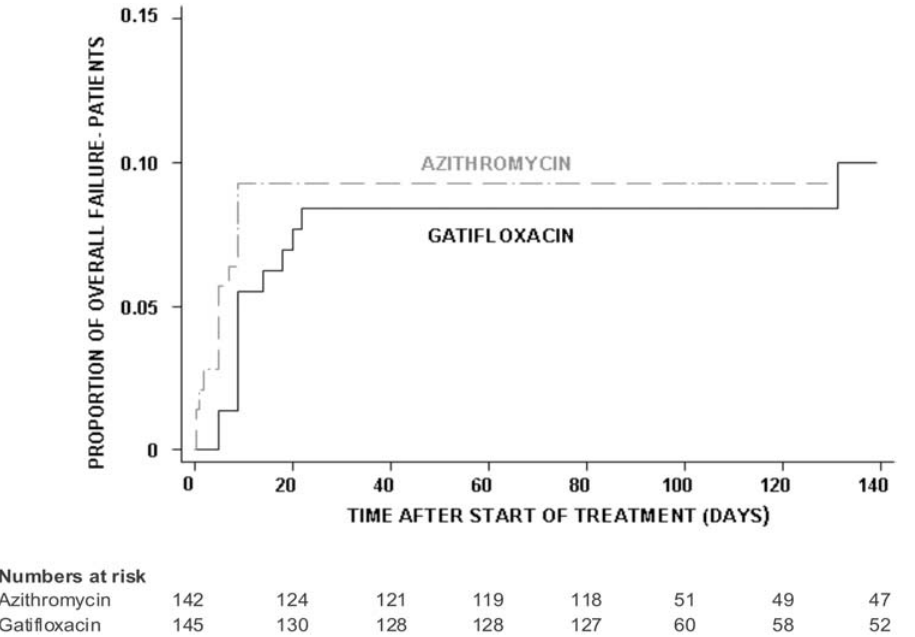
Figure 4. Proportion of patients with overall failure in the culture confirmed population. Kaplan-Meier survival curve showing the proportion of patients with overall failure in the culture confirmed population (PP analysis) by treatment